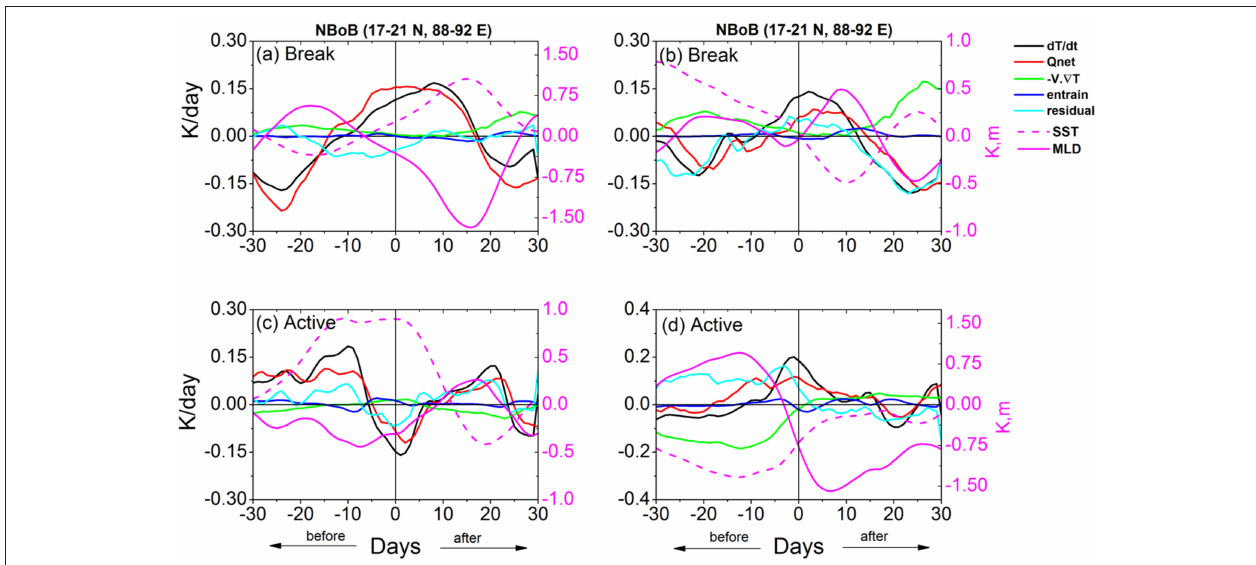
FIGURE 8 | Temporal evolution of various ML heat budget terms, in CFSv2 model solutions, for a typical extended (a) break and (c) active event averaged over NBoB; (b,d) shows inconsistent ML heat budget evolution. For completeness of the budget we have superposed SST (solid magenta line; units in K) and MLT (dashed magenta line; units in m) anomalies. Note, that MLT anomalies scaled to match with SST amplitudes. All other units of the ML budget terms are ( ◦ K/day). X-axis represents the time evolution from − 30 to + 30 days.